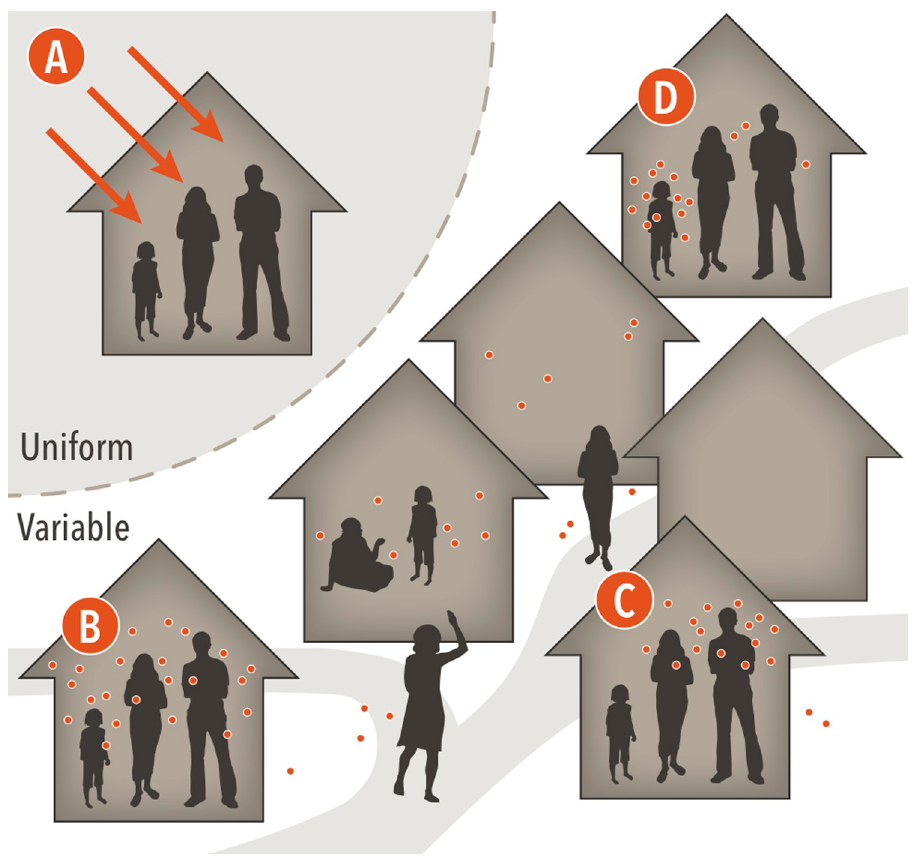
Fig 2. Four distinct assumptions about heterogeneous DENV exposure. Scenario A represents homogeneous transmission of DENV ignoring mosquitoes and human movement patterns, leading to everyone experiencing the same hazard of exposure to any serotype of DENV. In scenarios B, C, and D, DENV is transmitted by mosquitoes, and human and mosquito movement patterns are considered. Scenario B represents homogeneous attractiveness of different humans to mosquitoes at a given location. Scenario C represents human attractiveness to mosquitoes proportional to human body size. Scenario D represents heterogeneous human attractiveness to mosquitoes based on a gamma distribution with shape 1.43 and scale 1, regardless of their body